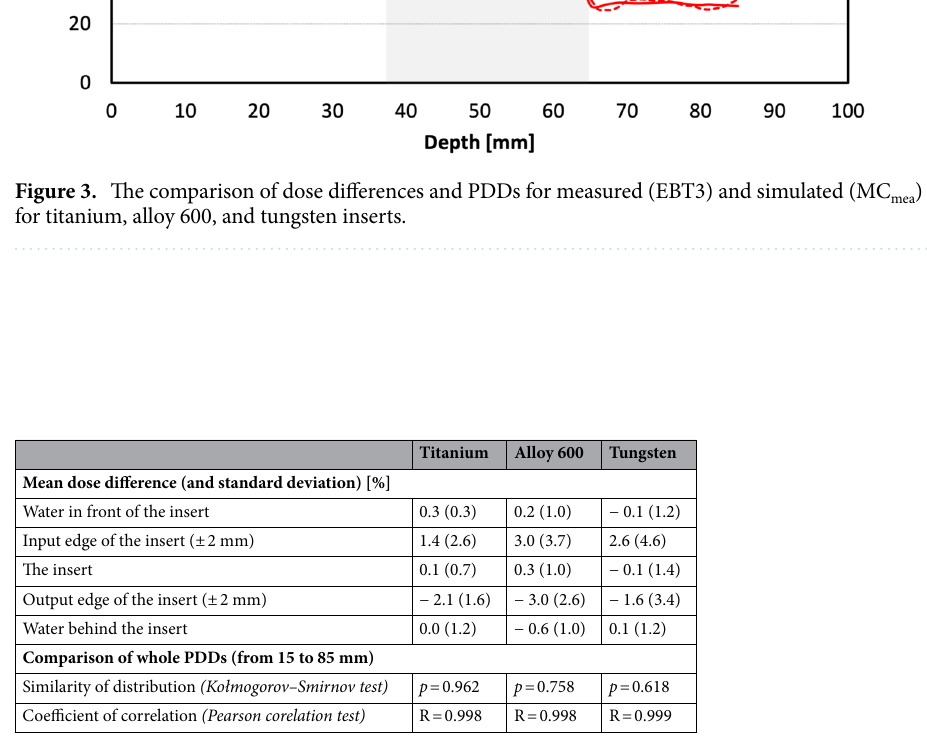
Table 1. Measured (EBT3) and simulated (MC mea : Monte Carlo; measurement conditions) percentage depth doses, and mean dose difference (EBT3—MC mea ) for selected regions.